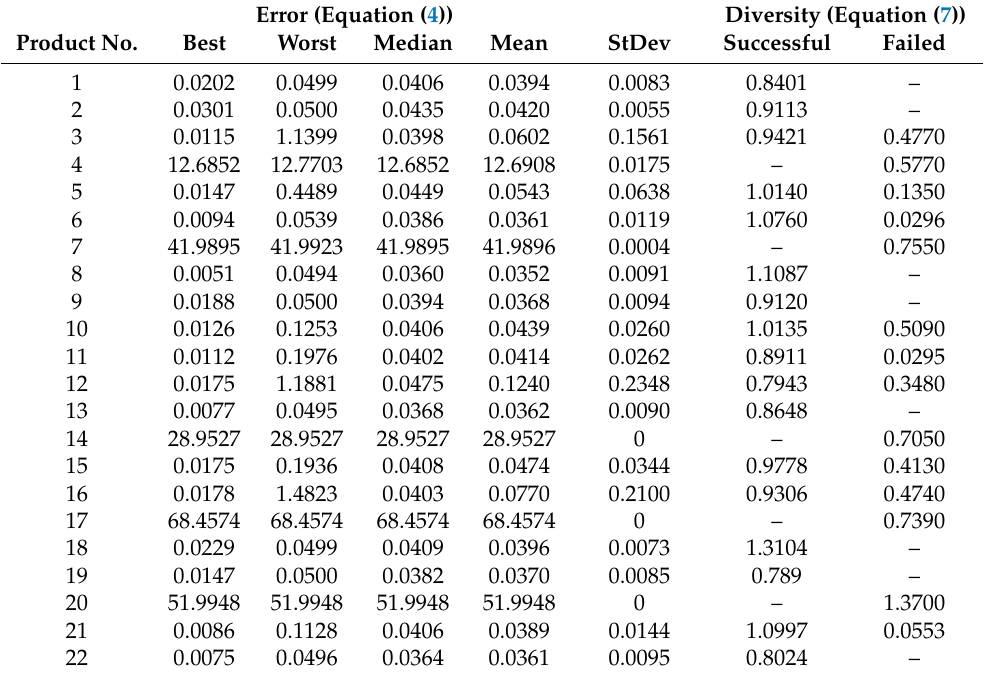
Table 3. Performance results in error and diversity. Error (Equation